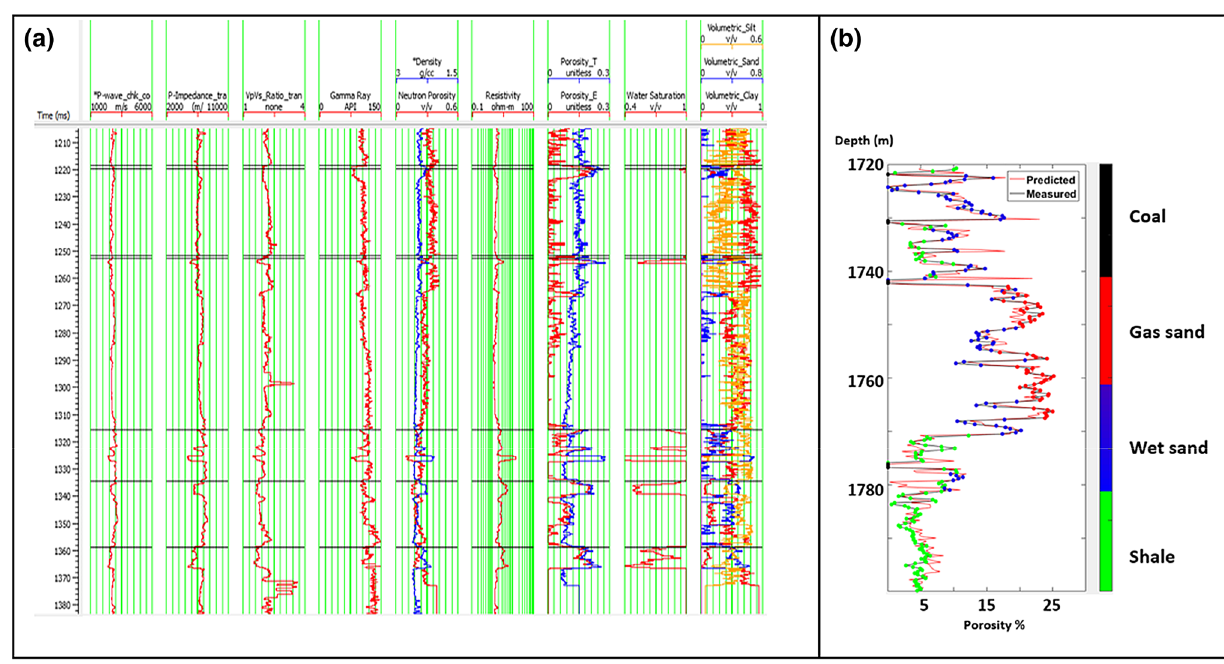
Fig. 4 a Elastic logs, raw logs and petrophysical interpretation logs. b Measured porosity superimposed on predicted porosity derived from petrophysical seismic inversion color coded by identified lithofacies classes within selected interval of